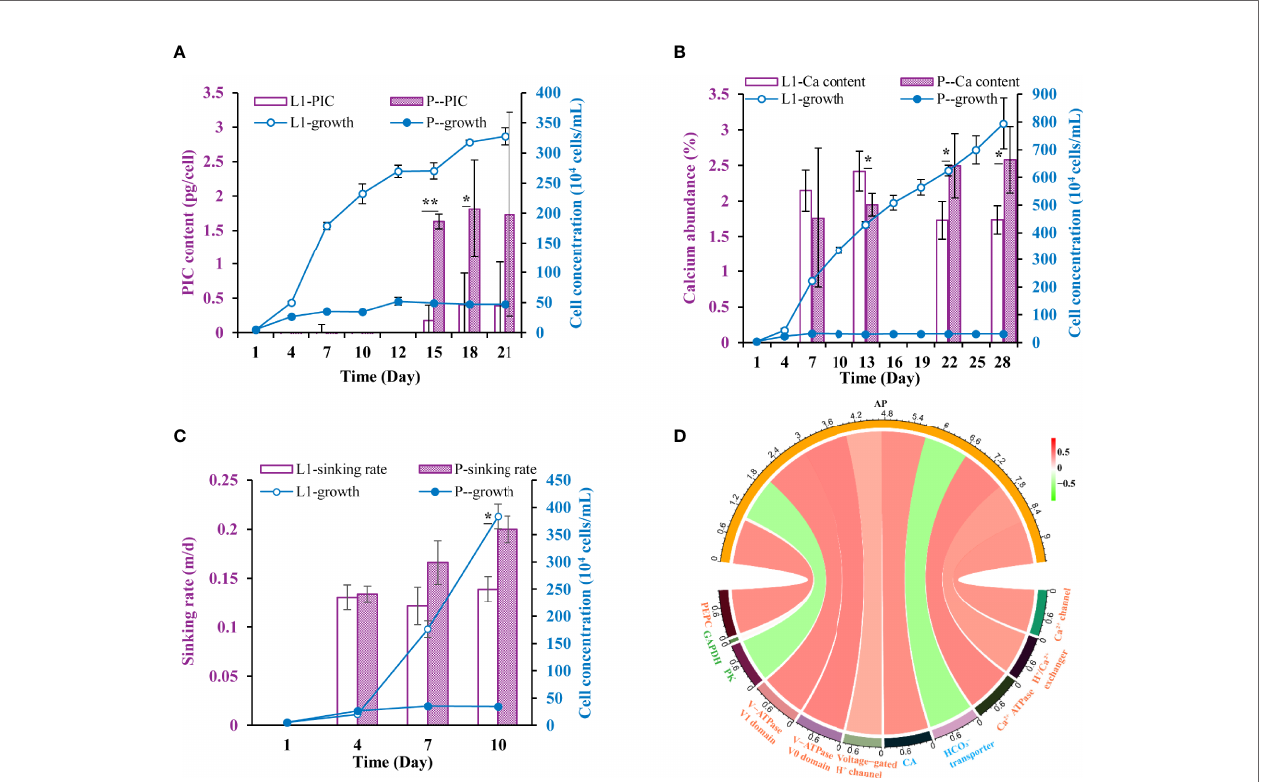
FIGURE 4 | Physiological responses and the underlying molecular mechanism under P-limited conditions. (A-C) Cellular particulate inorganic carbon (PIC), calcium abundance, sinking rate in L1 and P- cultures. * indicates p < 0.05 in t -test while ** indicates p < 0.001. Error bars denote ± s.d. of the mean (n = 3). (D) Circos plot displaying the correlation between the expression of AP genes and that of calci fi cation and photosynthesis related genes. The red ribbon indicates positive correlations while the green ribbon indicates negative